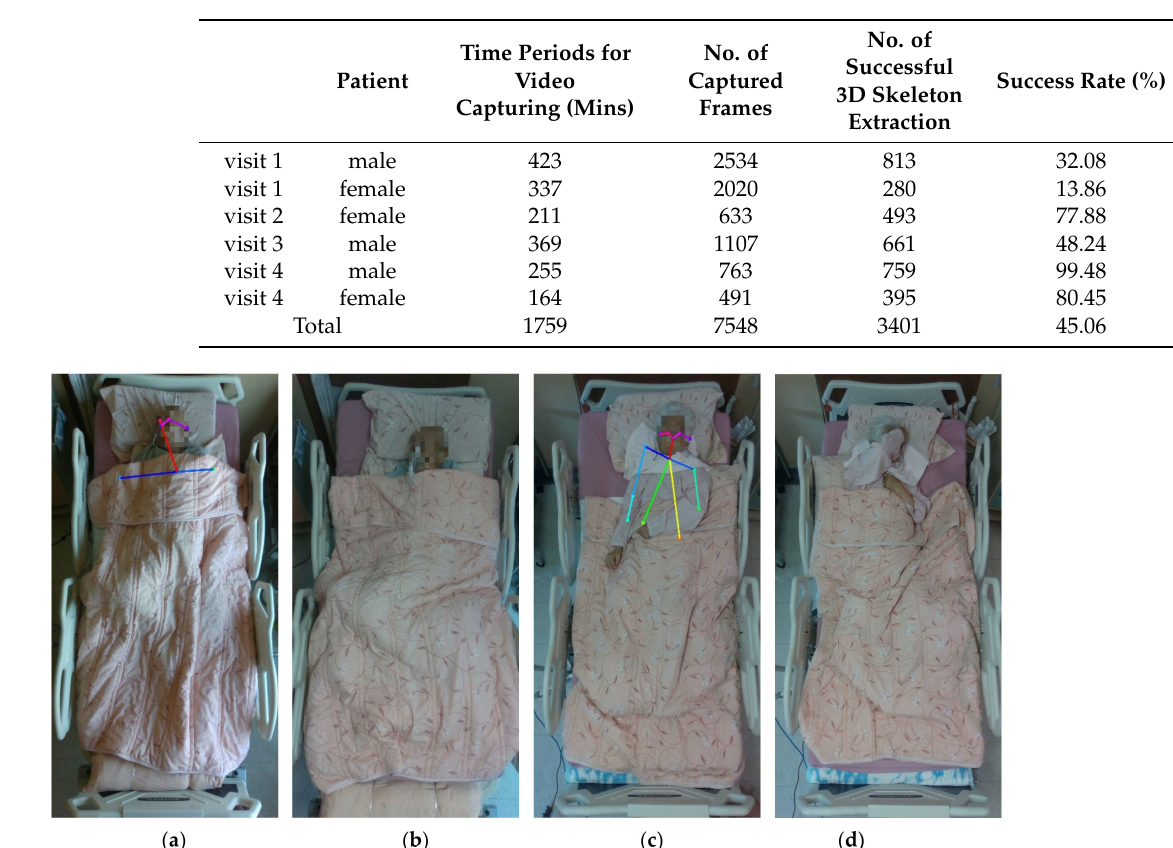
Table 10. Statistics of our clinic video data collection.